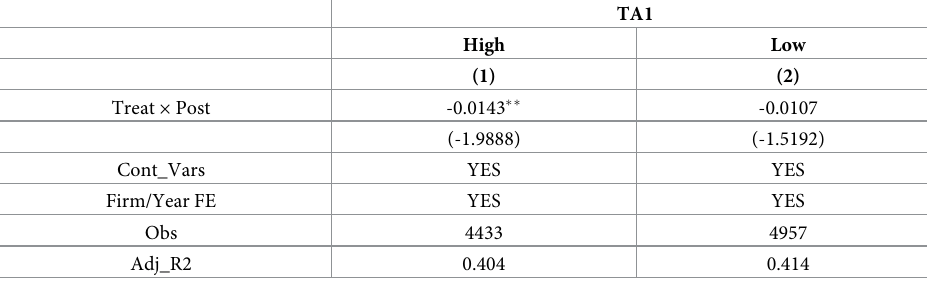
Table 8. Heterogeneity analysis: Industry